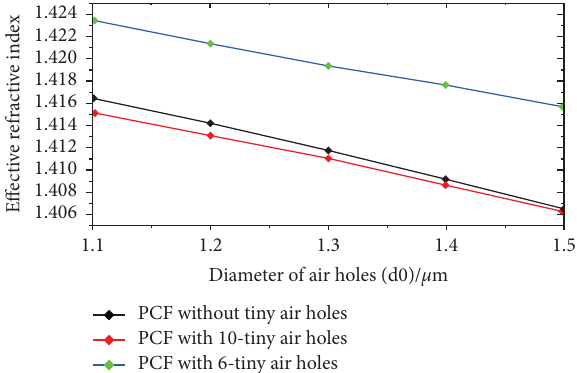
Figure 5: Plot of efective refractive index as a function of the diameter of air holes at a constant pitch size of Λ � 2.2 μ m and λ � 1.55 µ m for all the PCF structures.